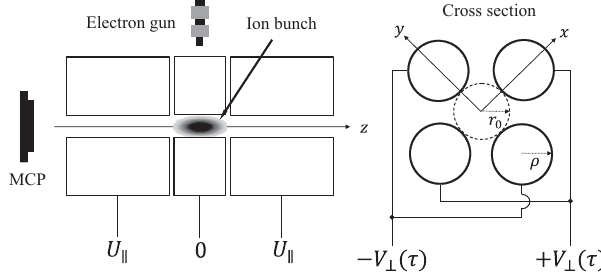
FIG. 1. Schematic drawing of the LPT for short-bunch experi- ment. The LPT consists of three quadrupole sections electrically isolated from each other. The transverse rf quadrupole field of the same strength is always excited in all three sections. The central section, in which ions are stored, is 8.9 mm long; this length is determined so as to make the axial potential well nearly parabolic when an equal DC bias voltage is applied to the two end sections of 30 mm long. An electron gun is placed above the central section to ionize neutral Ar atoms. The radii of the aperture and quadrupole rods are r 0 ¼ 5 mm and ρ ¼ 5 . 75 mm. The DC bias U k on the MCP side is dropped to extract remaining ions and count them with the